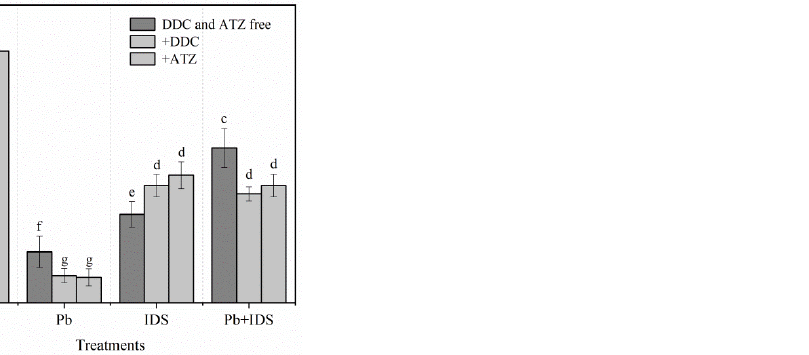
Figure 8. Effects of Pb, IDS, and Pb+IDS on NOX activities of maize seeds. Maize seeds incubated with distilled water (control), Pb (20 mmol·dm −3 PbCl 2 ), IDS (100 mmol·dm −3 ), or Pb+IDS were used, and NOX activities were measured 1, 3, and 5 d after sowing. Error bars represent the standard deviation of the mean ( n = 5). Means associated with different letters are significantly different among treatments and time points ( p < 0.05; Duncan’s new multiple range test). Pb, lead; IDS, imi- nodisuccinic acid; NOX, NADPH oxidase.